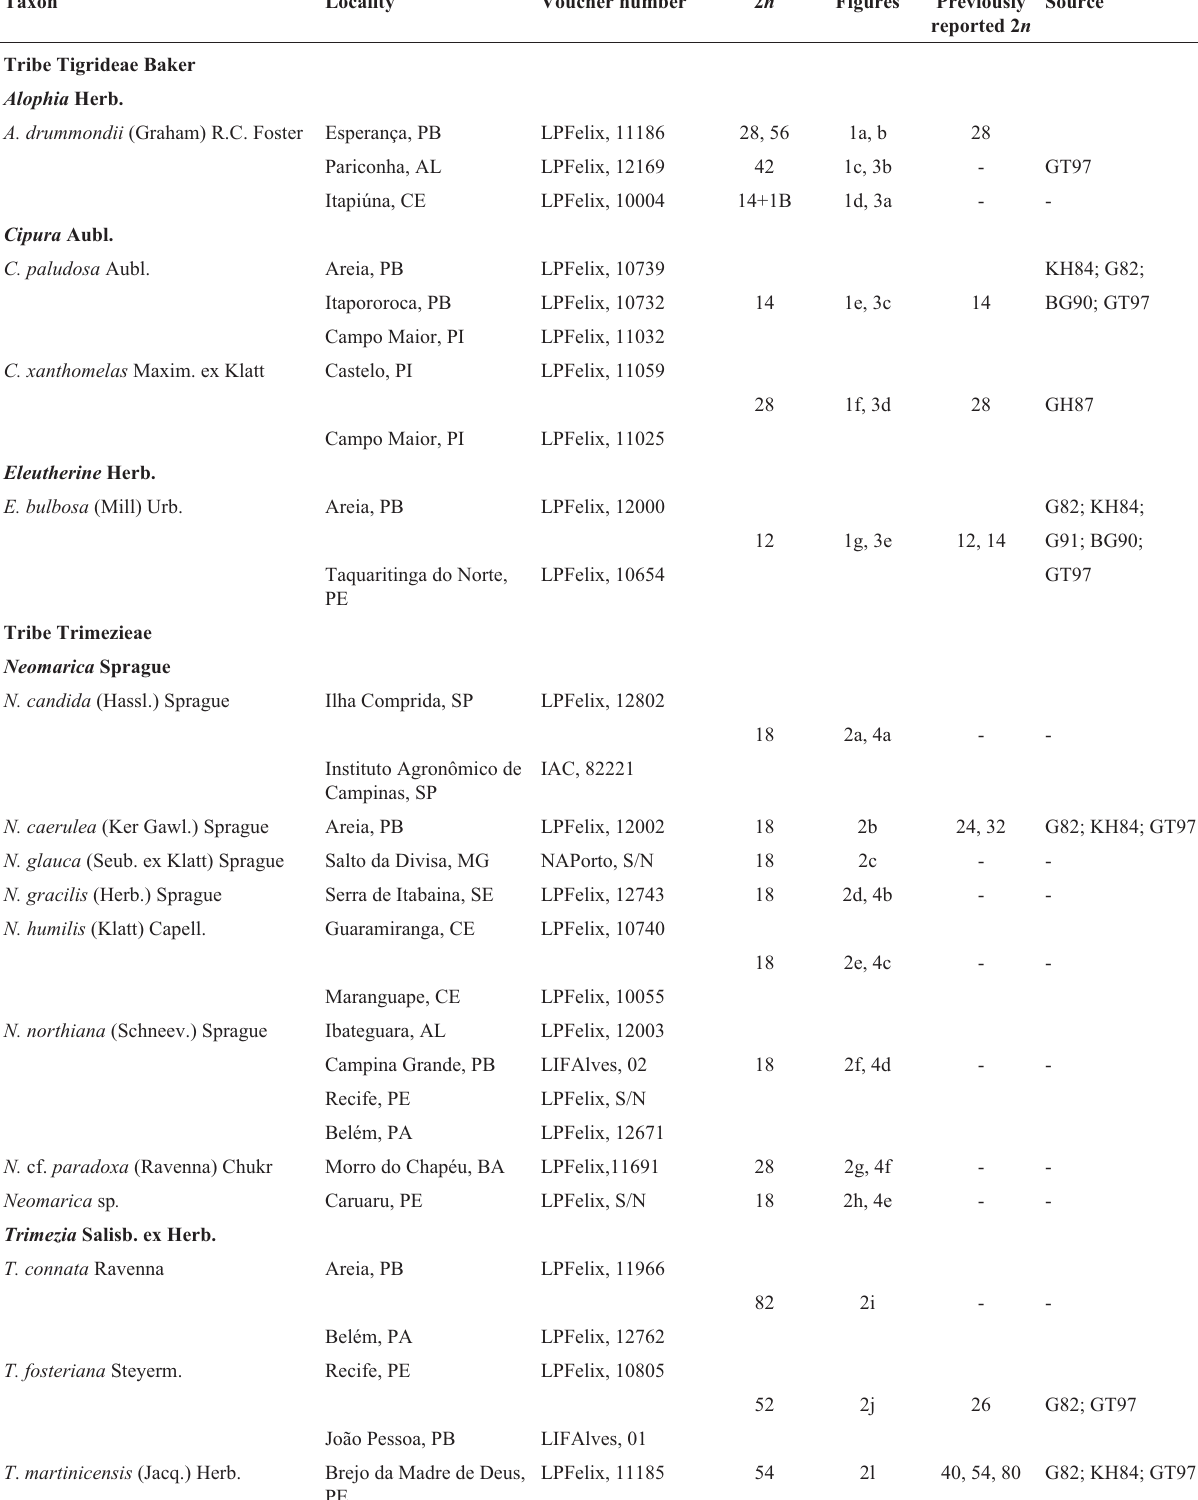
Table 1 - Diploid numbers of some Iridaceae species from the Brazilian Northeast. Diploid numbers indicated in bold were reported